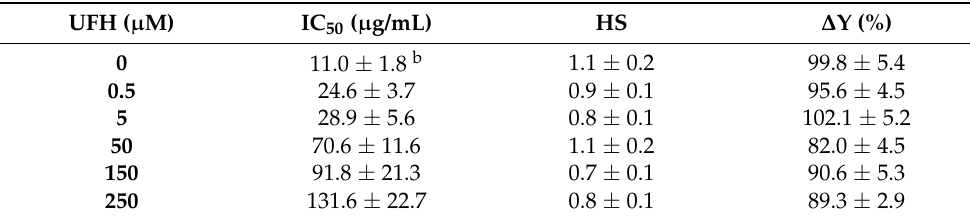
Figure 7. Competitive inhibition of human FXIa by LSAS in the presence of UFH. The FXIa inhibition was measured spectrophotometrically at 37 °C and pH 7.4. Solid lines represent fits by the dose– response Equation (1) to calculate the inhibition parameters. The concentrations of UFH elected for the experiment were 0 ( ● ), 0.5 ( ○ ), 5 ( ▲ ), 50 ( ♦ ), and 250 ( ■ ) μ M. Table 3. Inhibition of human FXIa by LSAS in the presence of UFH under physiologically relevant conditions a .